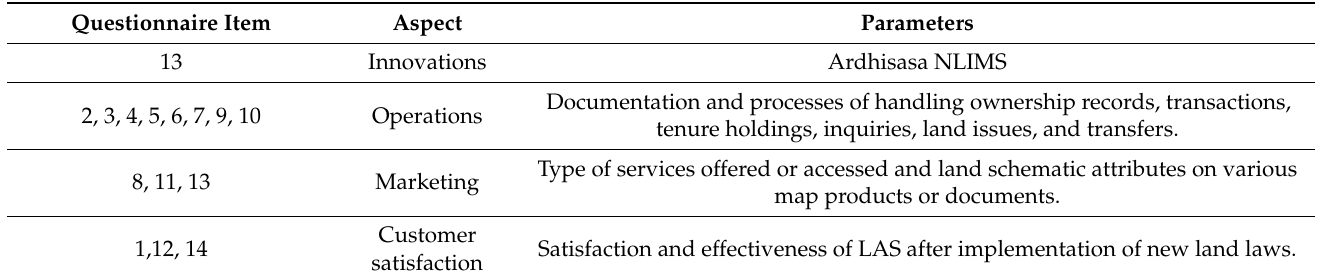
Table 2. Perspectives of the integrated performance management framework